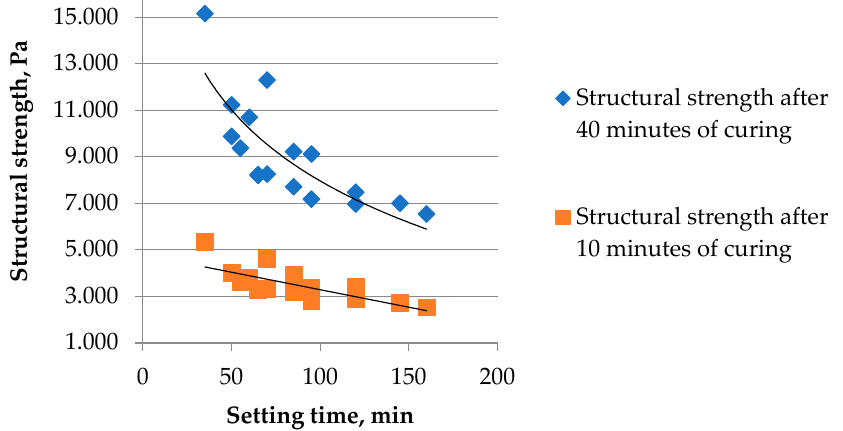
Figure 6. Relationship between setting time and structural strength of concrete.